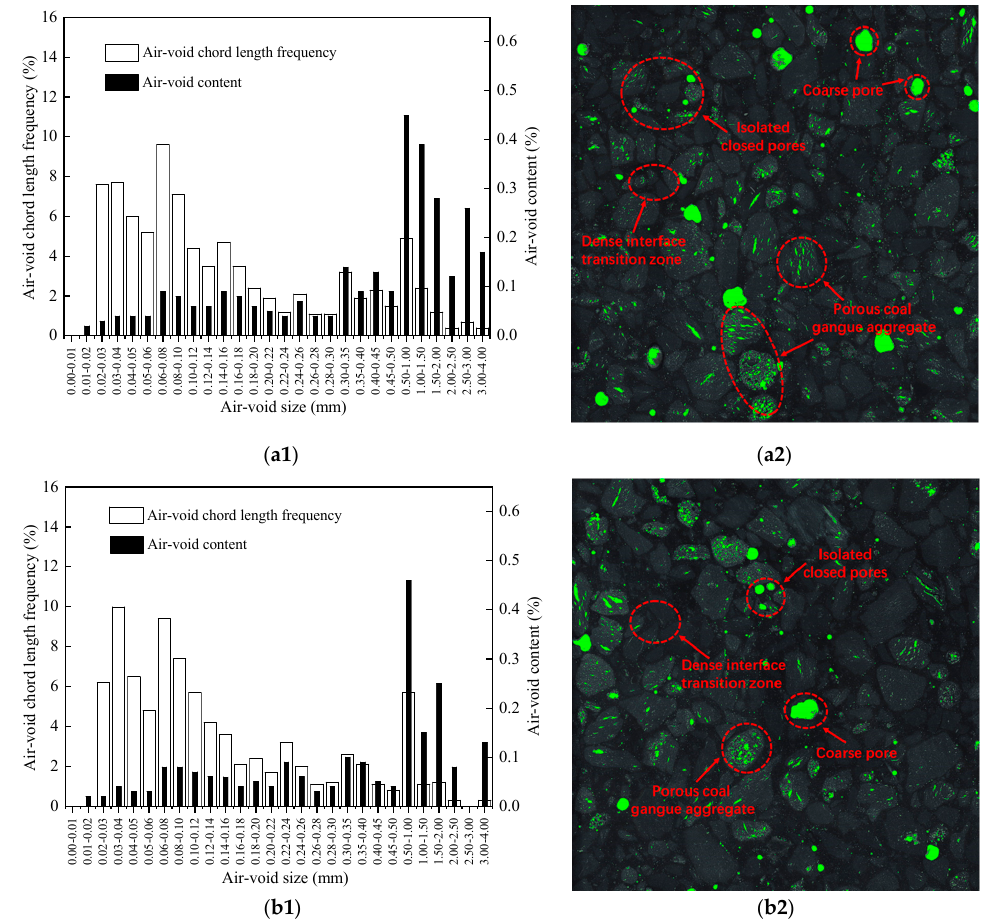
Figure 16. Air-void distribution and cross-sectional morphology of CGAC with ( a ) 10% cement substitution rate; ( b ) 40% cement substitution rate (1: Air-void distribution; 2: Cross-sectional morphology).